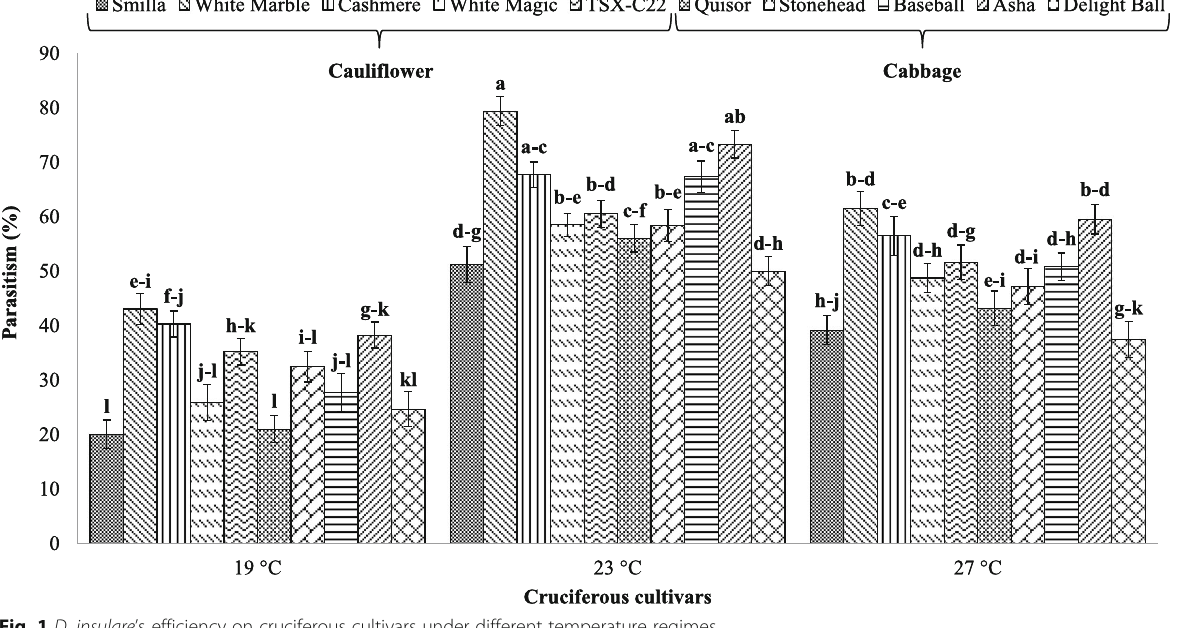
Fig. 1 D. insulare ’ s efficiency on cruciferous cultivars under different temperature